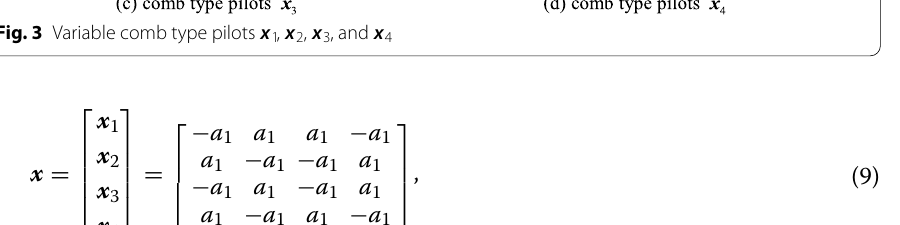
Fig. 3 Variable comb type pilots x 1 , x 2 , x 3 , and x